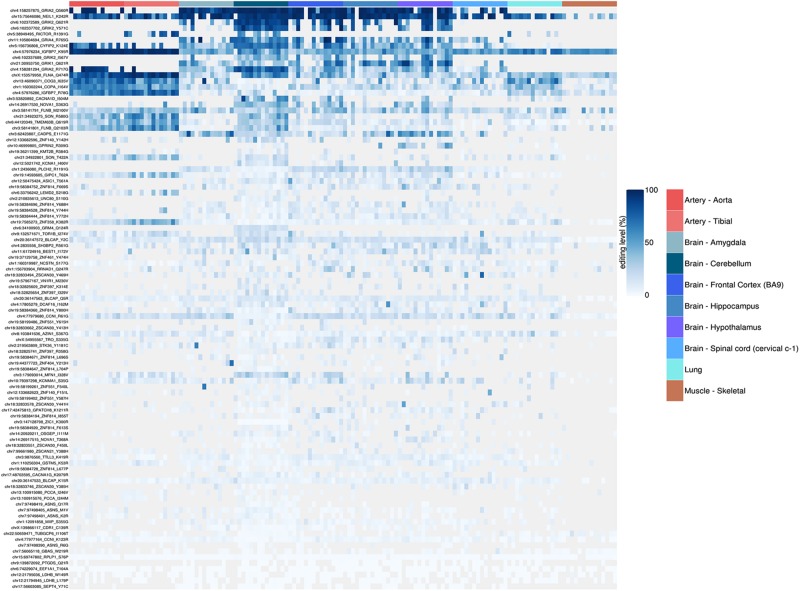
Heatmap representing RNA editing levels at 99 selected recoding events. Body sites are reported in the same order as in the previous box-plots and follow the same color code. The hierarchical clustering (dendrogram not shown) of the recoding sites shows how the artery (both aorta and tibial) are characterized by a very peculiar and specific set of strongly (>90%) edited sites, thus suggesting a possible key functional role of these sites in the vascular system.